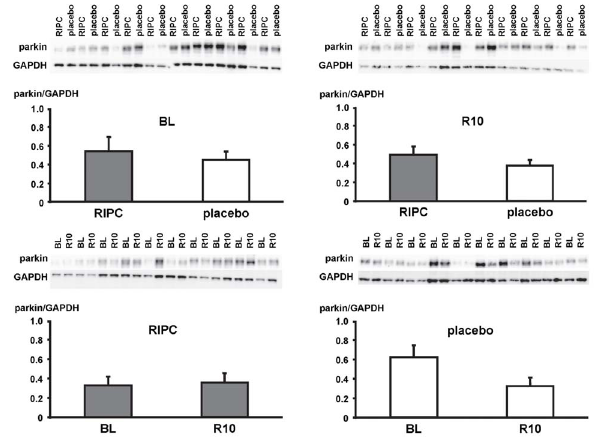
Figure 5. Expression of parkin. Original Western blots of protein content of parkin in myocardial biopsies obtained at baseline (BL) before initiation of cardiopulmonary bypass and at 5–10 min reperfu- sion (R10) from patients undergoing remote ischemic preconditioning (RIPC) or not (placebo). Immunoreactivity of parkin was normalized to glyceraldehyde 3-phosphate dehydrogenase (GAPDH). Ratios are presented in bar graphs.